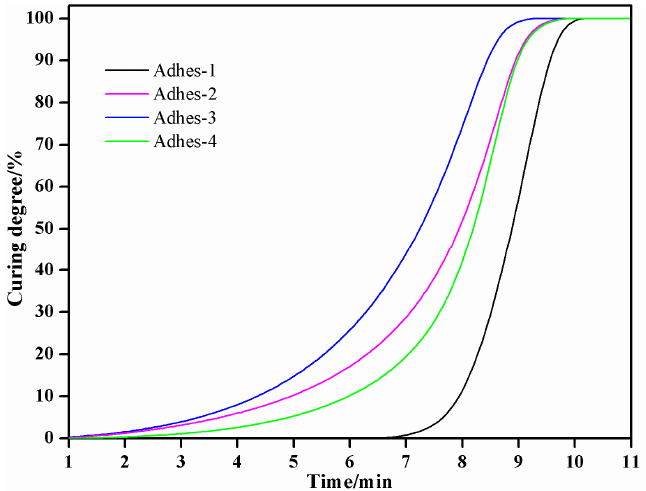
Figure 3. Degree of crosslinking reaction of Camellia oleifera cake-protein adhesives. Note: Adhes-1, the pure Camellia oleifera cake-protein adhesive; Adhes-2, Camellia oleifera cake-protein adhesive modified with DSP; Adhes-3, Camellia oleifera cake-protein adhesive modified with SPI; Adhes-4, Camellia oleifera cake-protein adhesive modified with